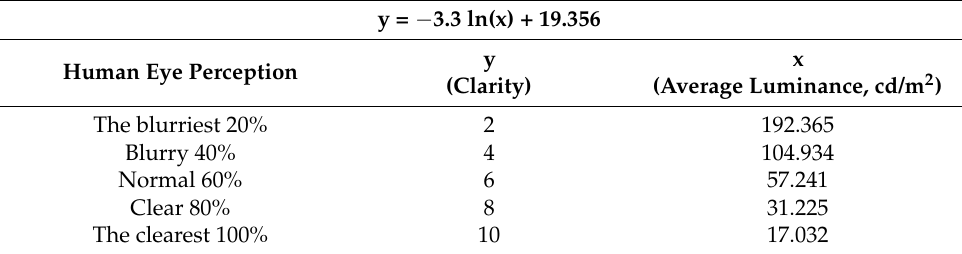
Figure 12. The trendline relates visual clarity and average luminance of the screen in case study. It is evident in Figure 12 that the average screen luminance and the visual clarity Table 6. Clarity to average luminance threshold in case study. score show an inverse proportion relationship. The higher the luminance on the screen,